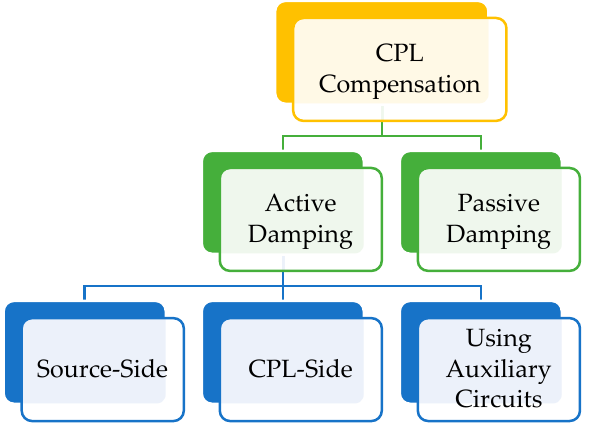
Figure 7. Broad classification of CPL compensation techniques.